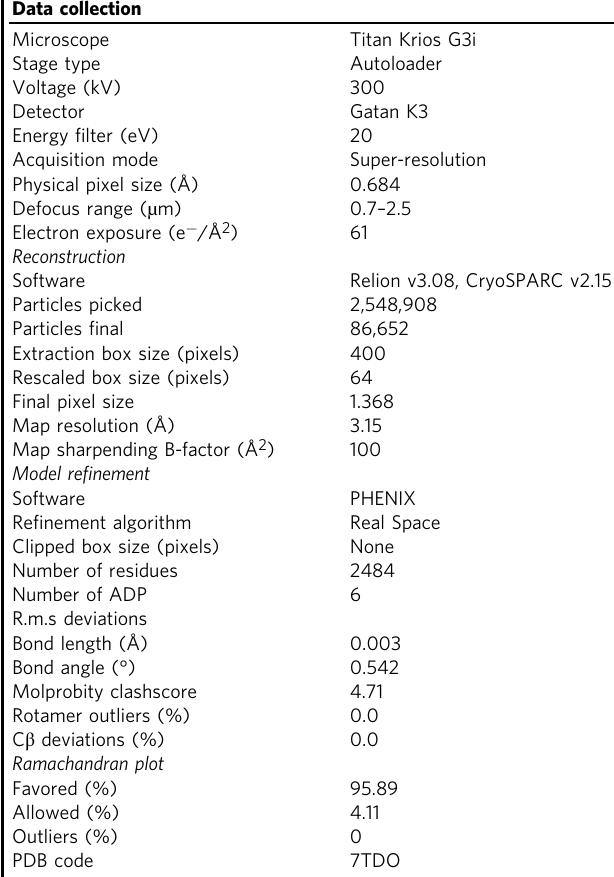
Table 1 Cryo-EM data collection, 3D reconstruction, and re fi nement